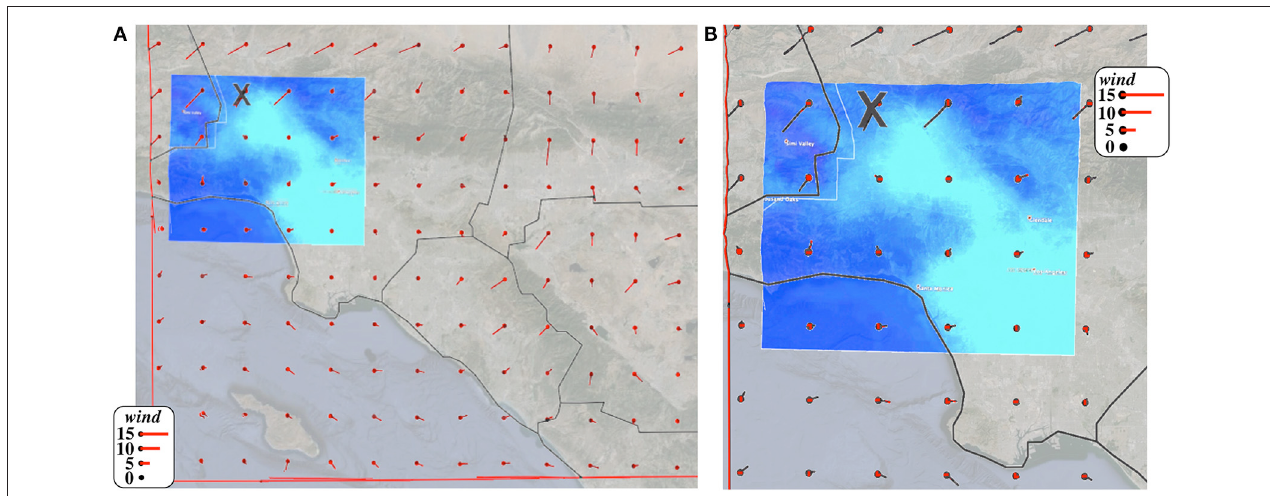
FIGURE 8 | Weather Regional Forecast (WRF) modeled surface (100m AGL) winds, for 13 November 2015, 2100UTM. (A) Large area view showing winds for much of the Los Angeles Basin. Also shown is the Aerosol Optical Depth (AOD) map from Figure 7 for reference only. (B) Zoomed in study